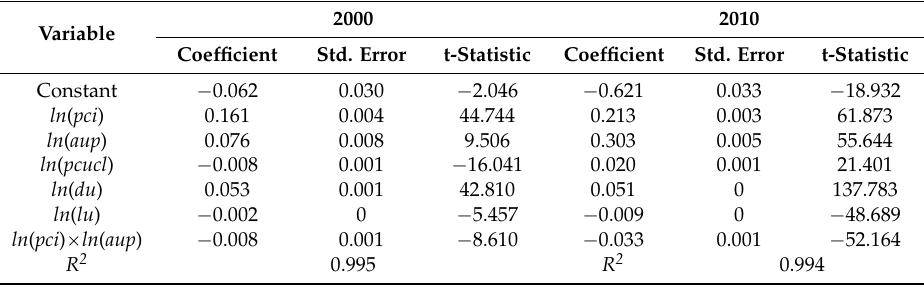
Table 7. Regression result of change in environmental benefits of urban land use.